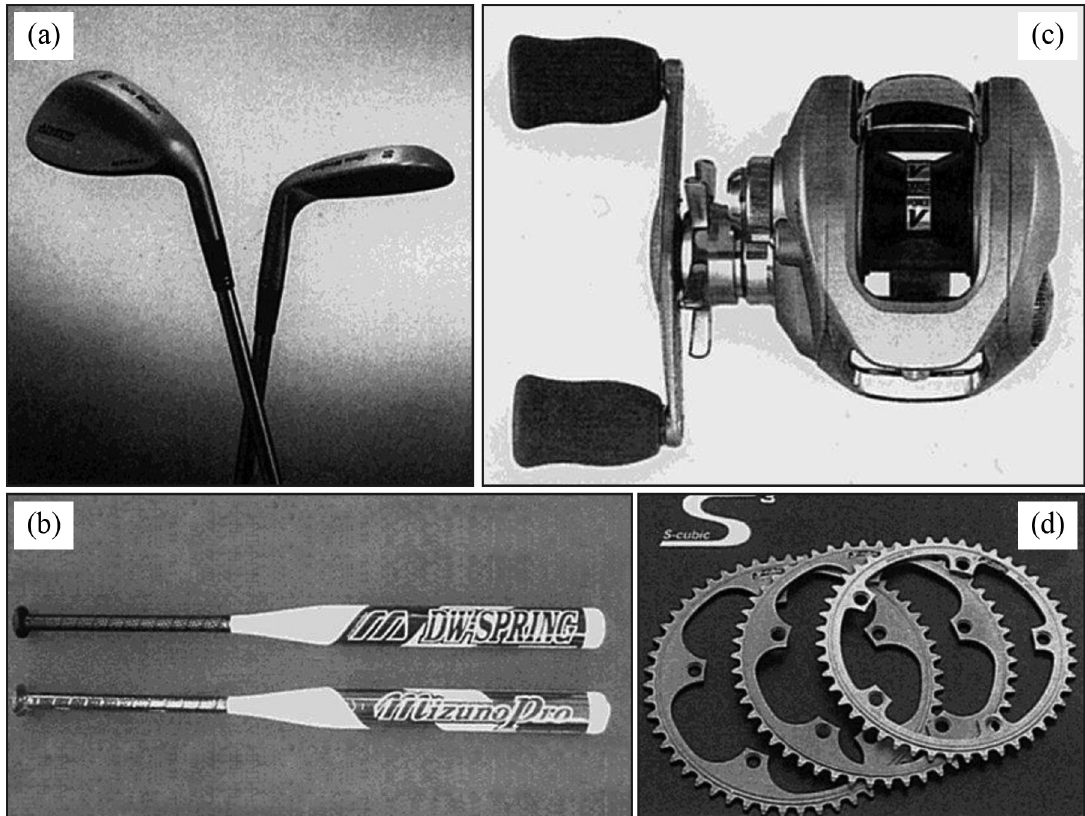
Figure 14. Application examples of nanocrystalline Al-based alloys: sporting goods (a, b), fishing reel (c) and gears in bicycle (d). These data were taken from YKK and Daiwa Corporations 42